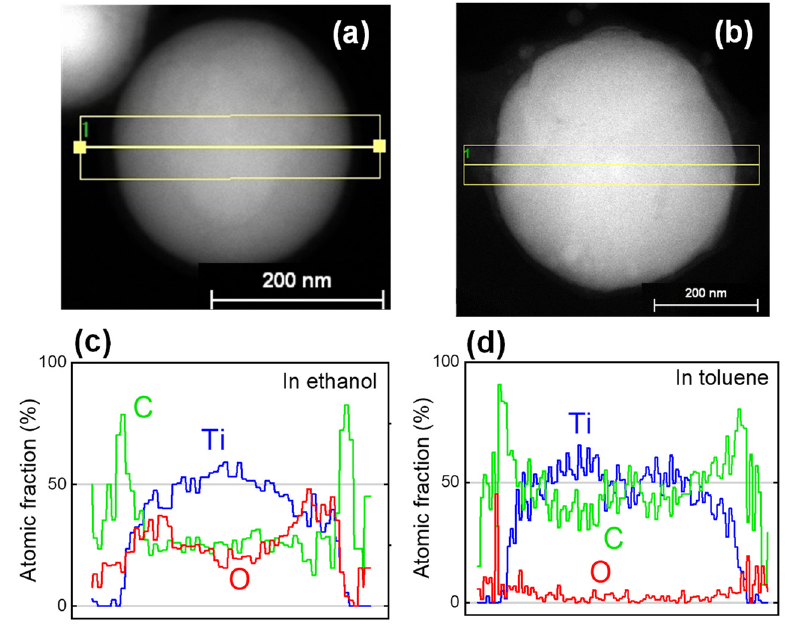
Figure 3. STEM images of TiC SMPs fabricated via PLML ( a ) in ethanol and ( b ) in toluene. The laser irradiation conditions were 532 nm Nd:YAG laser at 150 mJ pulse − 1 cm − 2 for 10 min in ethanol and 120 min in toluene. Compositional line scans of corresponding single particles obtained ( c ) in ethanol and ( d ) in toluene.